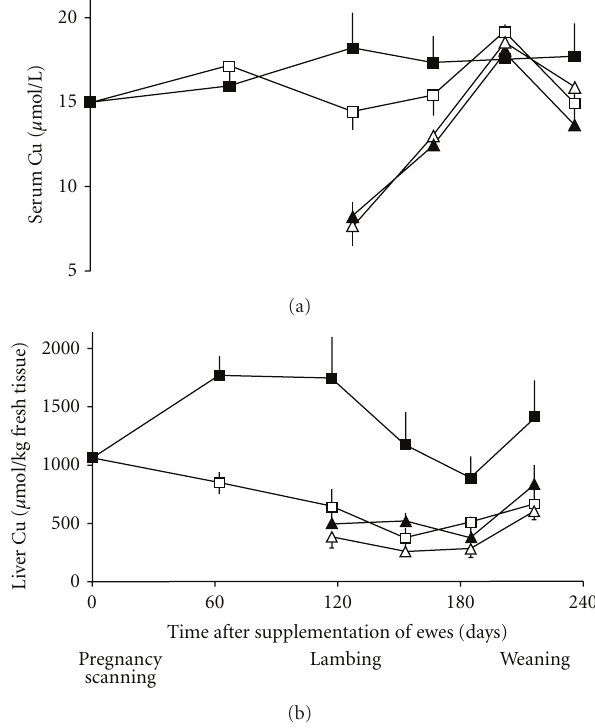
Figure 7: E ff ect of no treatment ( (cid:5) ) or bolus administration of 5g CuO wire particles (about 0.1 g Cu/kg LW) ( (cid:3) ) administered to pregnant ewes early in gestation on the concentrations of Cu in (a) serum, and (b) liver of ewes ( (cid:5) , (cid:3) ) and their lambs ( (cid:4) , (cid:2) ). Although the flock was not initially Cu deficient, e ffi cacy of CuO particles was demonstrated by changes in liver Cu concentrations